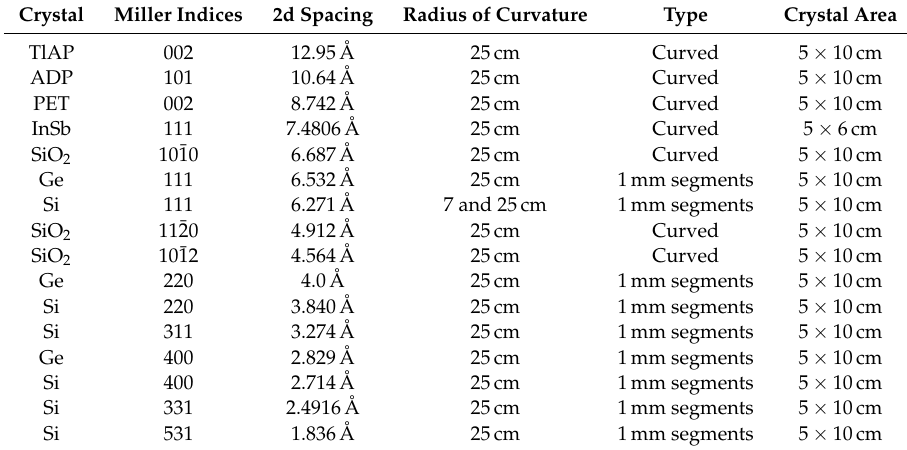
Table 3. List of von Hamos geometry spectrometer crystals available for use at either ESA Prime or ESA Flex. Note that higher-order reflections have been omitted for clarity. Curved means smooth crystals, segmented mean diced along the focusing axis, but perfect flat crystals along the dispersive axis